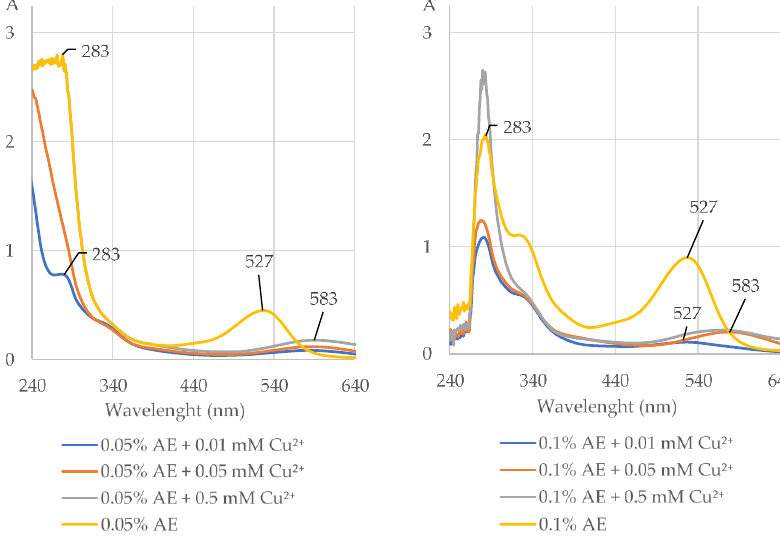
Figure 3. The UV–Vis absorption spectra (with indicated maximum absorption) of the extract from Aronia melanocarpa L. berries (0.05% and 0.1% AE) alone and after addition of divalent ions of copper (Cu 2 + ) at the concentrations of 0.01, 0.05, and 0.5 mM at pH 5.5. The shift of the maximum absorption after addition of Cu 2 + to the AE indicates that the extract chelated these ions. A,